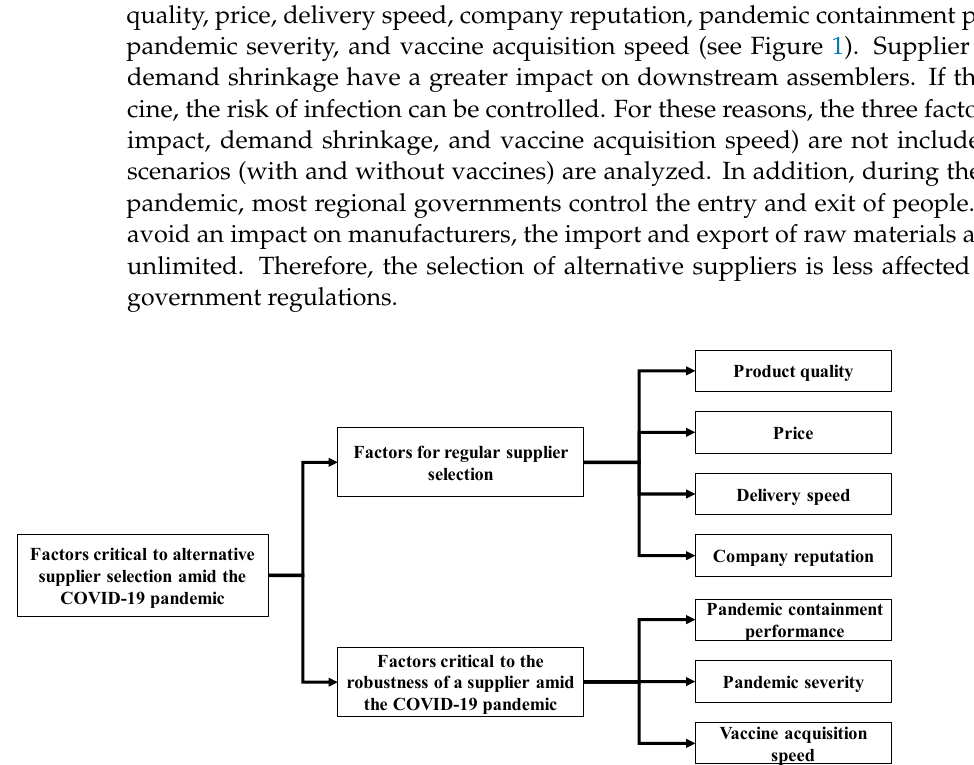
Figure 1. Factors critical to the selection of an alternative supplier amid the coronavirus disease 2019 (COVID-19) pan- demic.